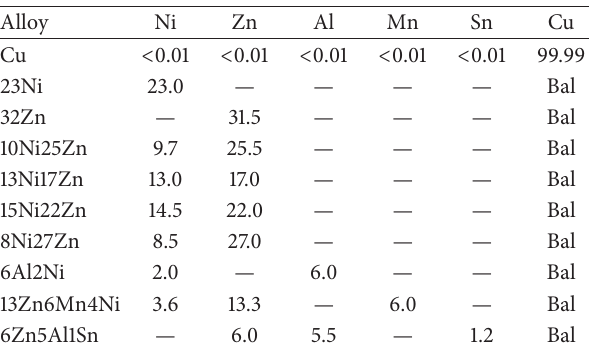
Table 1: Chemical composition of the Cu-based coins (wt.%).